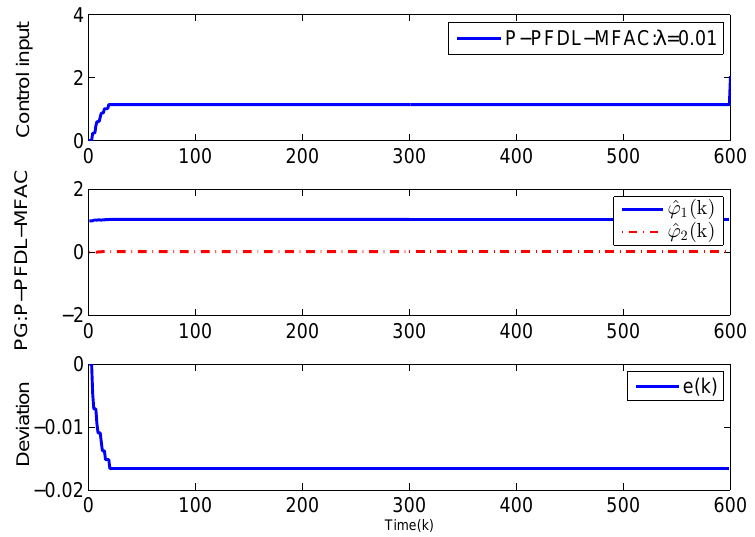
Figure 3. The curves of control input, PG estimation values, and